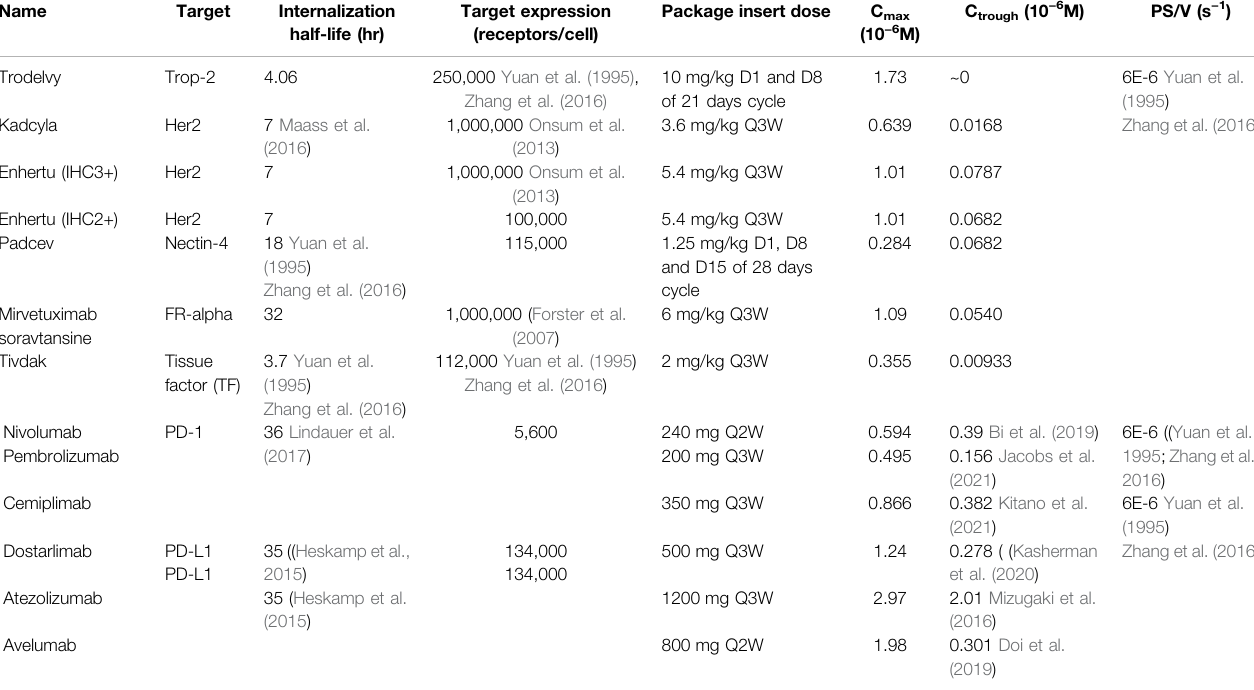
TABLE 1 | A summary of package insert doses and targets of fi ve FDA approved ADCs and seven checkpoint